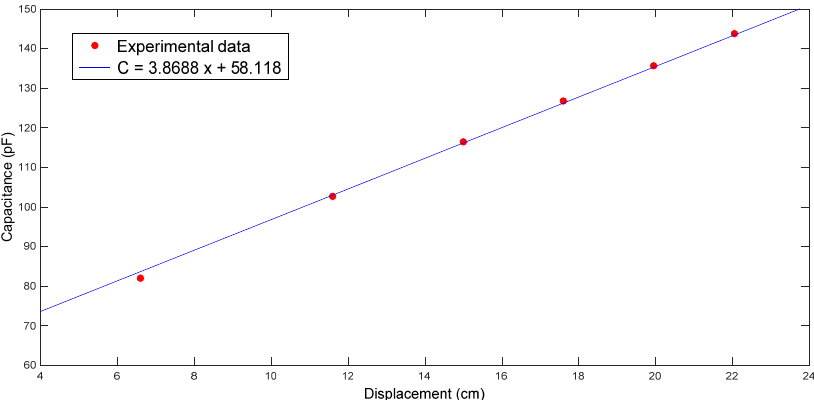
Figure 11. Relationship between flow front displacement and capacitance in the first RTM experiment using a nine-layer fiber preform.